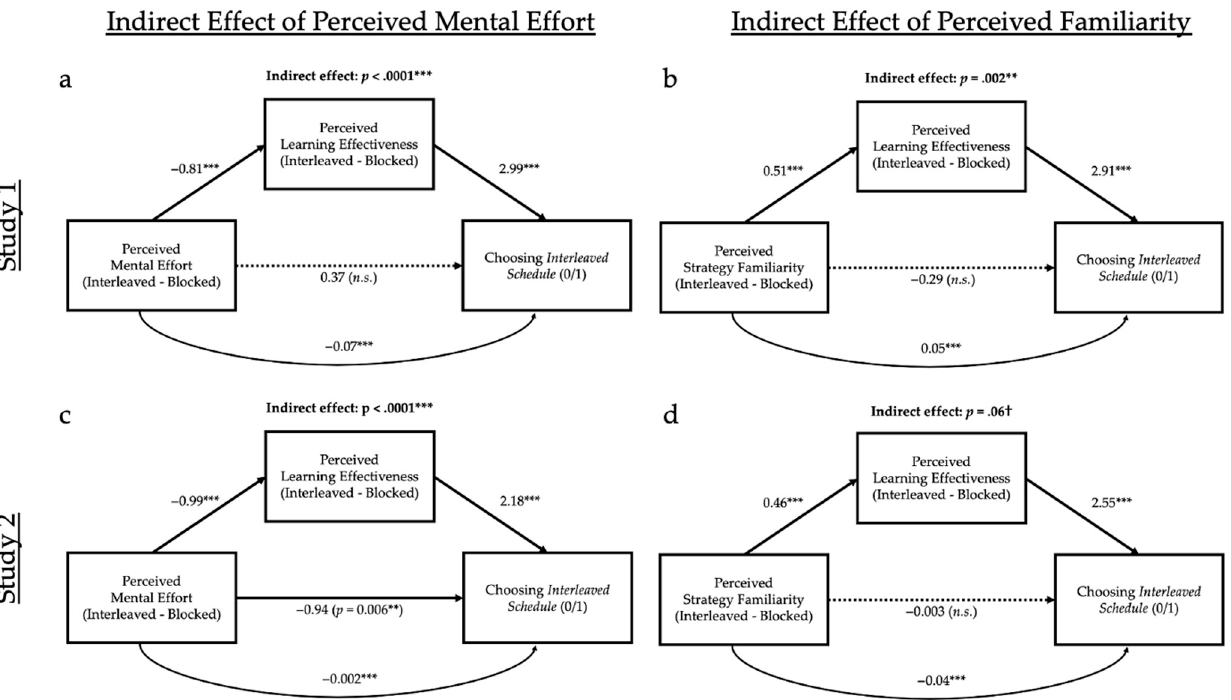
Figure 5. Bootstrapped mediation analyses for Study 1 for the unstandardized effects of mental ef- fort ( a ) and familiarity ( b ) using the retrospective semantic-differential measures; bootstrapped mediation analyses for Study 2 for the unstandardized effects of mental effort ( c ) and familiarity ( d ) using the retrospective semantic-di ff erential measures. † < .10, ** p < .01, *** p < .001.